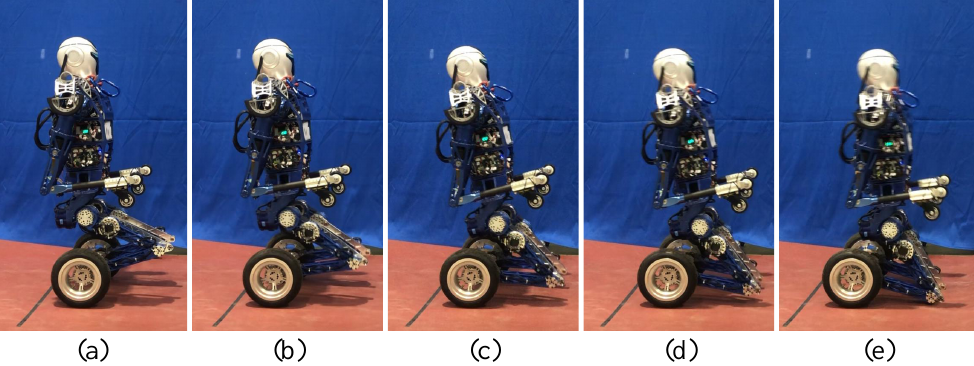
Figure 14. The transition experiment of the robot from the upright balanced moving mode to kneeling on the ground: ( a ) Balanced standing; ( b – e ) From balanced standing to